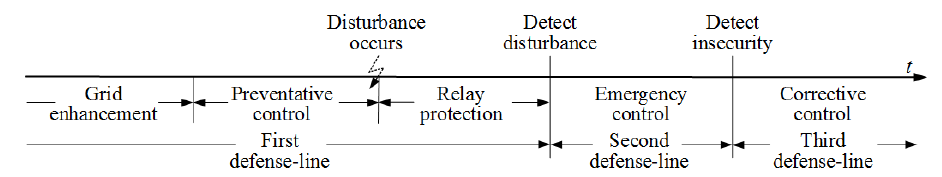
Figure 3. Schematic diagram of three defense-lines.